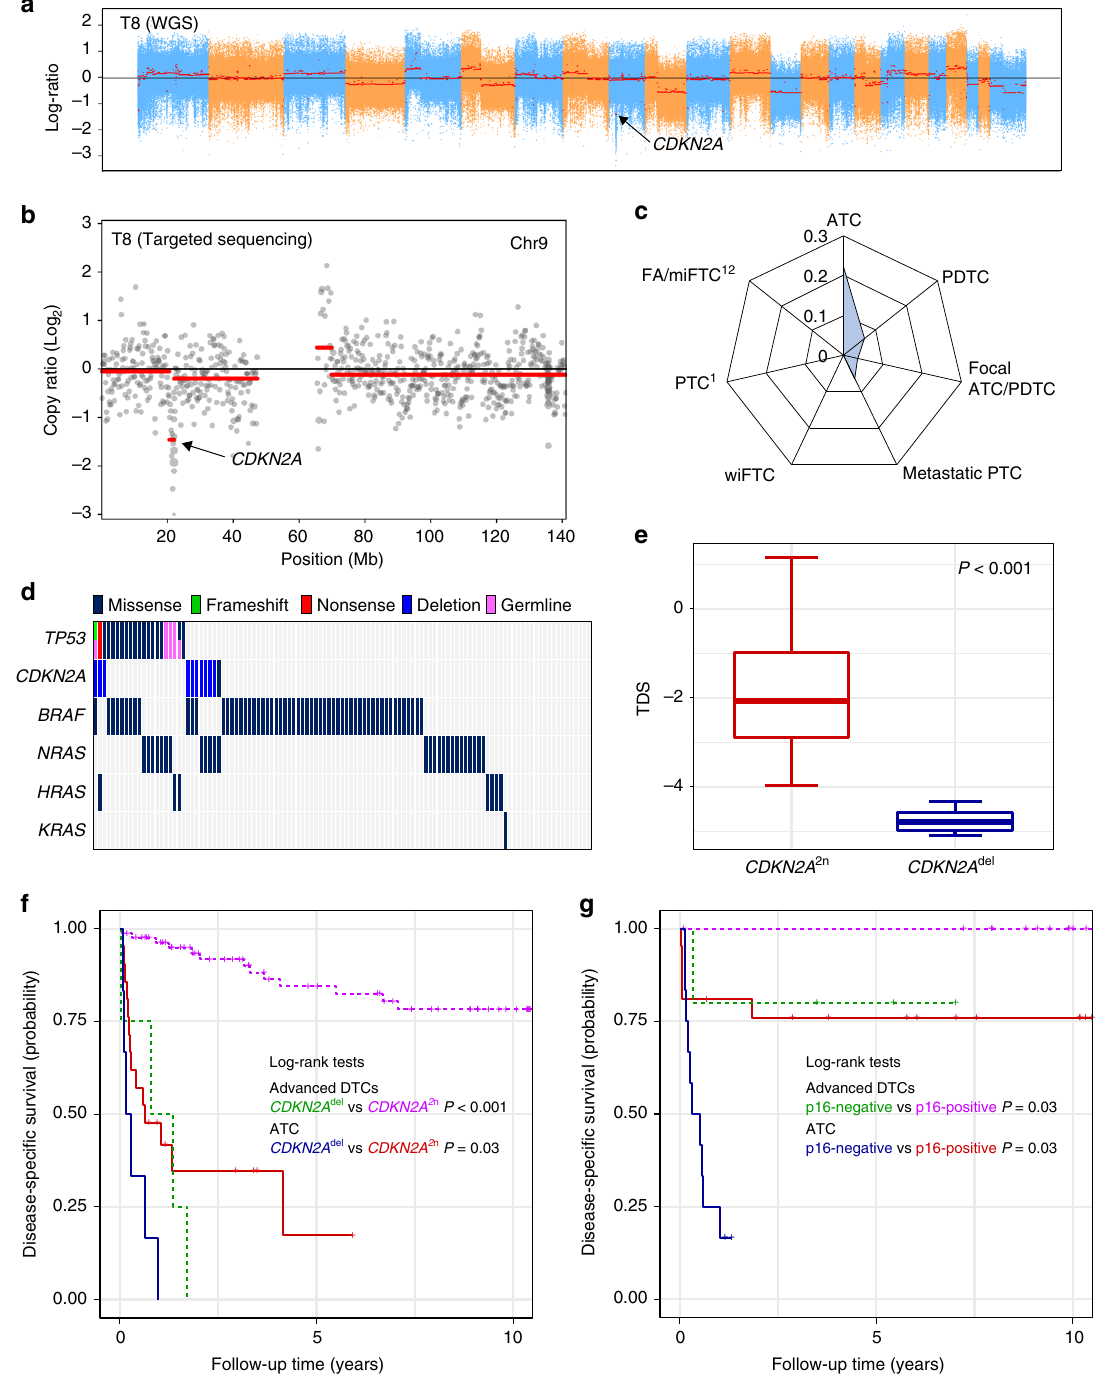
Fig. 3 CDKN2A loss in ATC and advanced DTCs. a Detection of CDKN2A loss in ATC using WGS. b Detection of CDKN2A loss in ATC using targeted sequencing. c The frequency of CDKN2A loss among diverse types of TC were represented by a radar chart. d The distribution of TP53 and CDKN2A alterations across 113 advanced TCs. e The effect of CDKN2A loss on thyroid differentiation score (TDS) in ATC. P -values from two-tailed Mann – Whitney U -test were represented. f The effect of CDKN2A loss on disease-speci fi c survival in patients with ATC and advanced DTCs. del and 2 n indicate CDKN2A copy number loss and neutral, respectively. g The effect of p16 expression on disease-speci fi c survival in patients with ATC and advanced DTCs. P -values from Log-rank test were